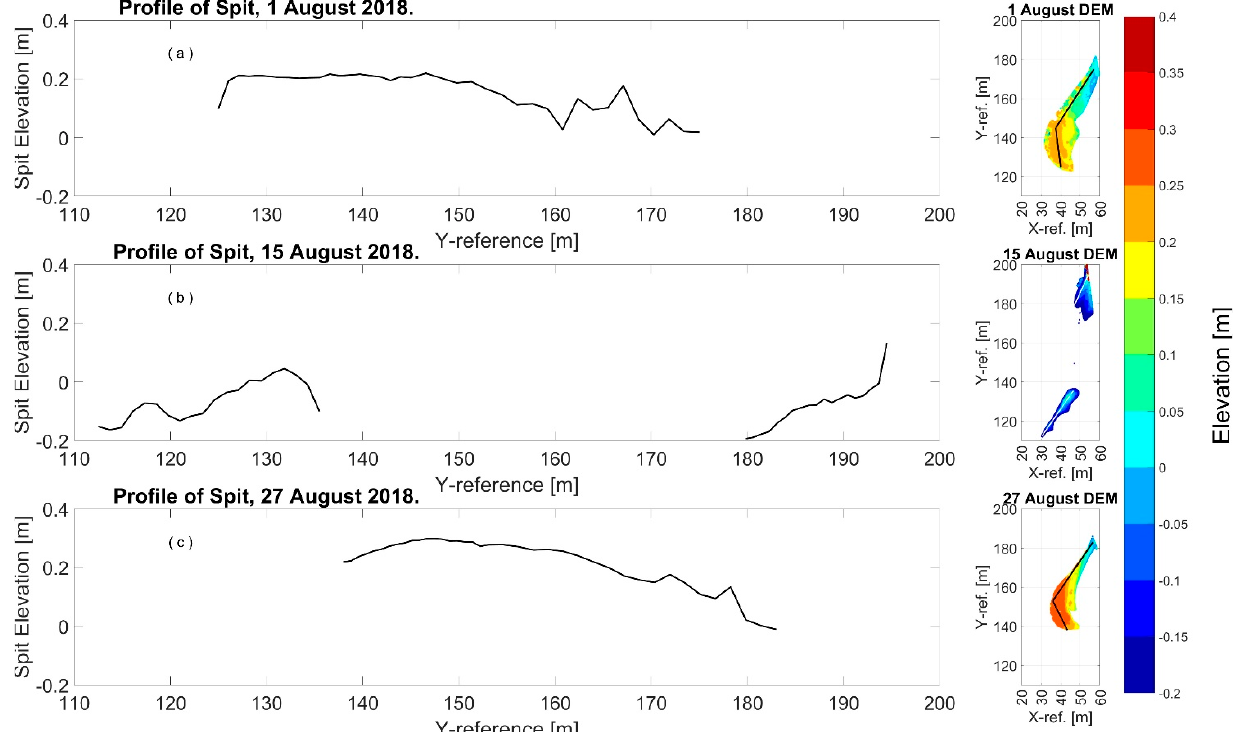
Figure 6. Spit profiles from ( a ) 1 August, ( b ) 15 August, and ( c ) 27 August, showing the spit before breaching, the breached spit, and the new spit profile, respectively. Right column panels show the digital elevation model, and the black lines (or white in the middle panel) are where the profiles (left panels) were computed.